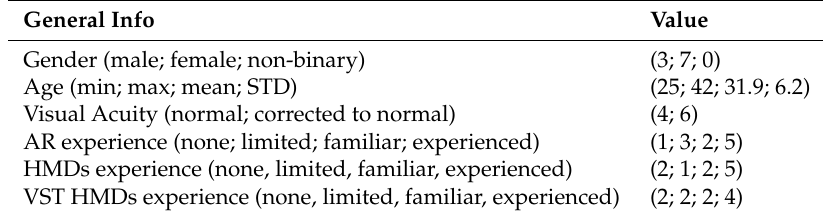
Table 1. Demographics of the ten participants to the user